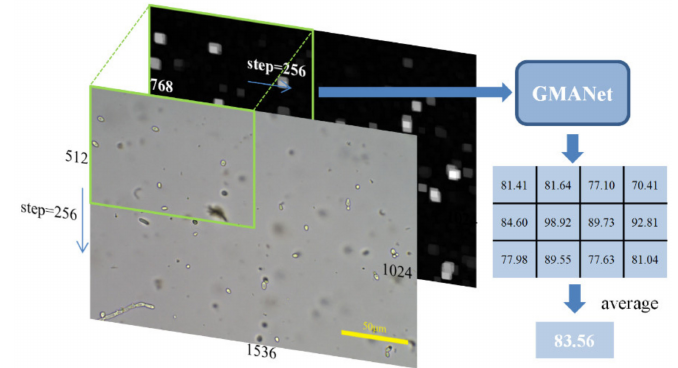
Figure 4. The inference process of proposed